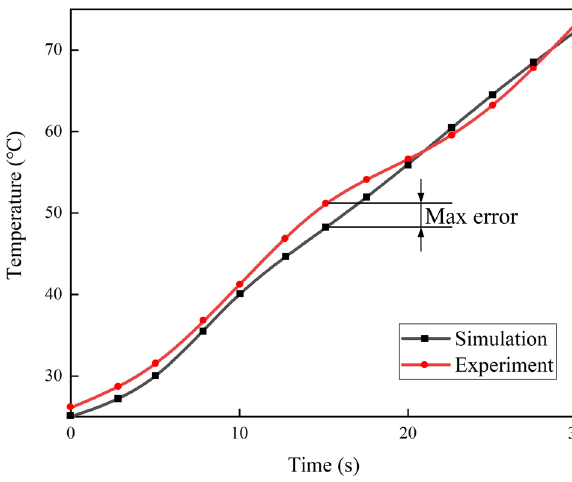
Figure 7: ( a ) Displacement boundary conditions and temperature fi eld, ( b ) heat transfer boundary conditions, and ( c ) meshing of modeling.